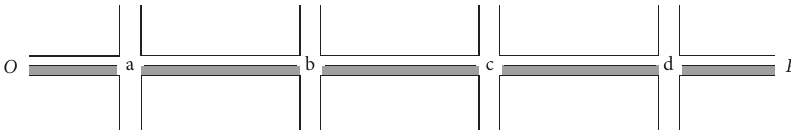
Figure 15: The sample traffic in a subnetwork. The grey links indicate heavy traffic status. In this case, the proposed method gives more green cycle time to vertical routes than horizontal routes. Giving more green cycle time to horizontal routes does not improve traffic status because vehicles cannot move from ( O ) to ( a ) and from ( a ) to ( b ), while making vertical route green causes to avoid traffic jam on vertical direction.